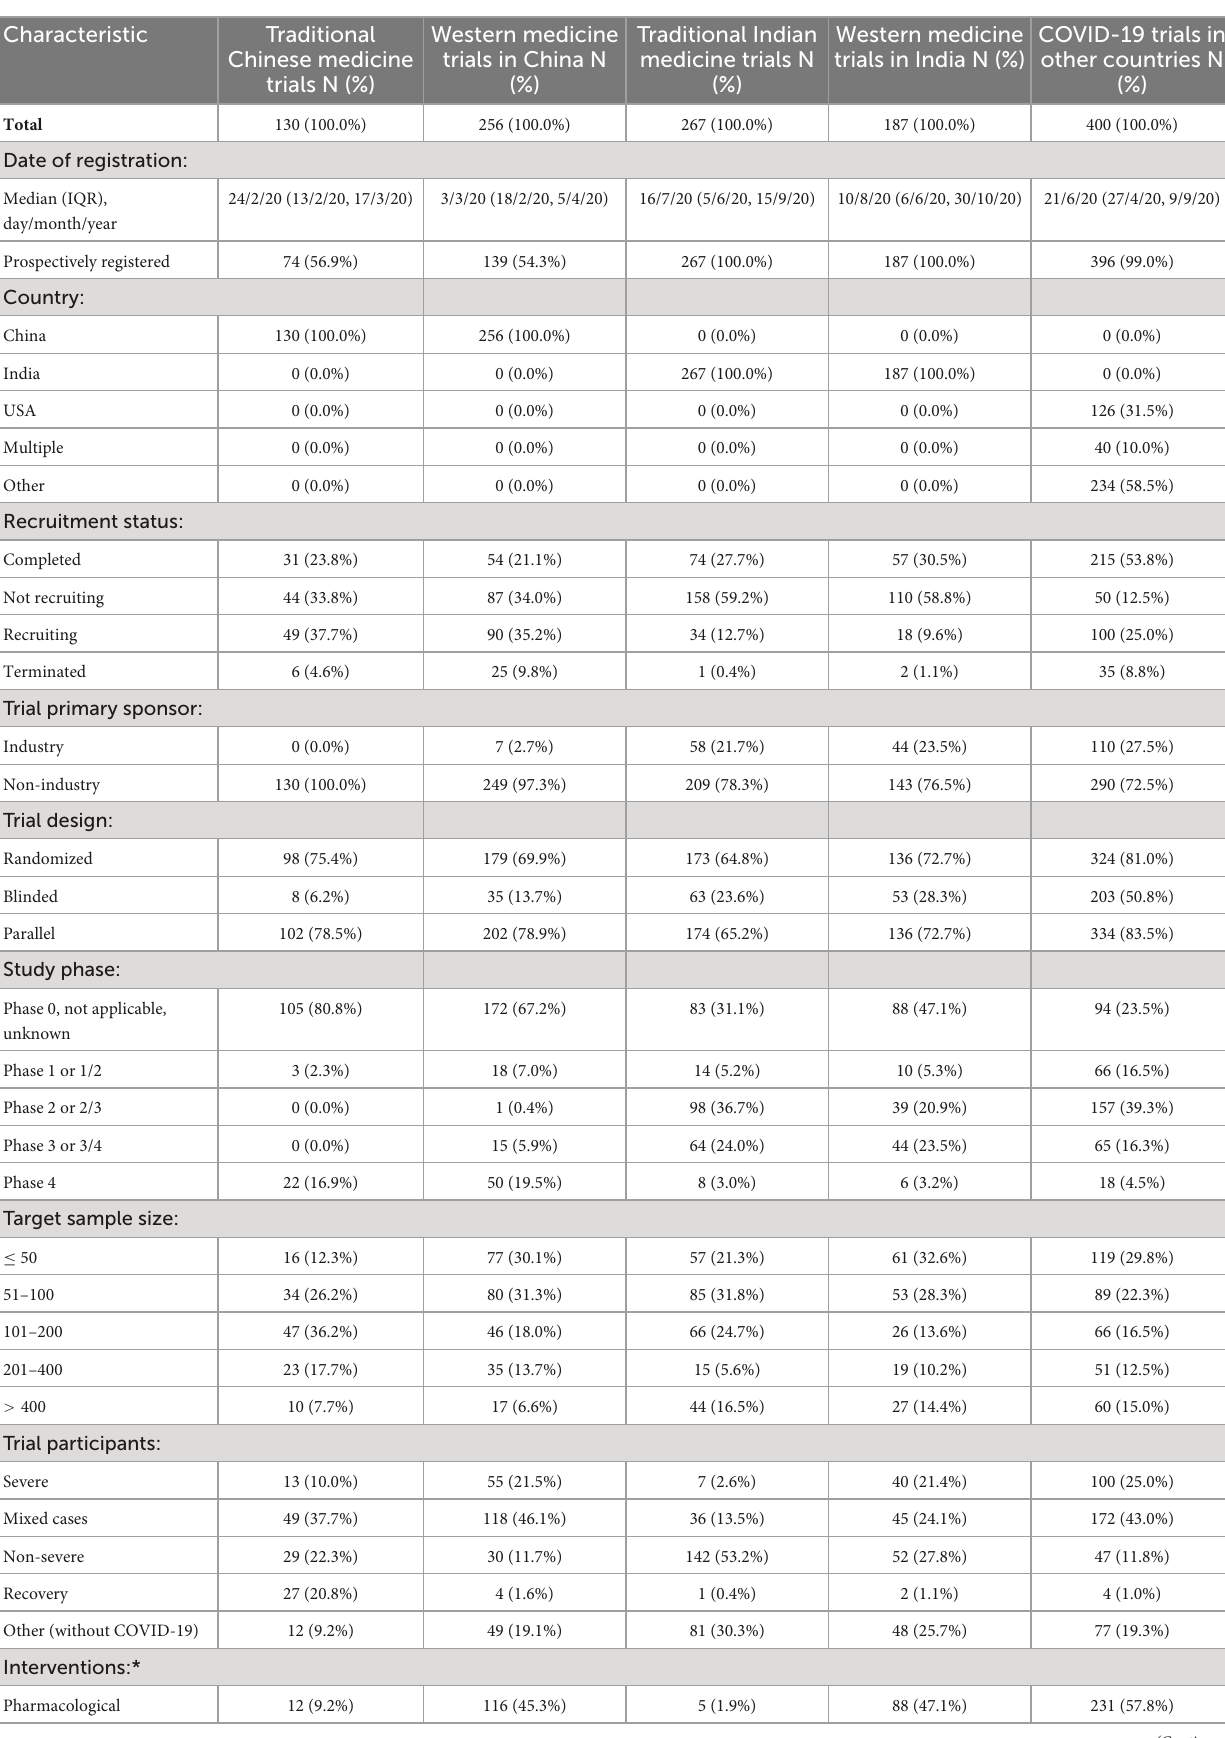
TABLE 1 The main characteristics of registered COVID-19 clinical trials included in the study.